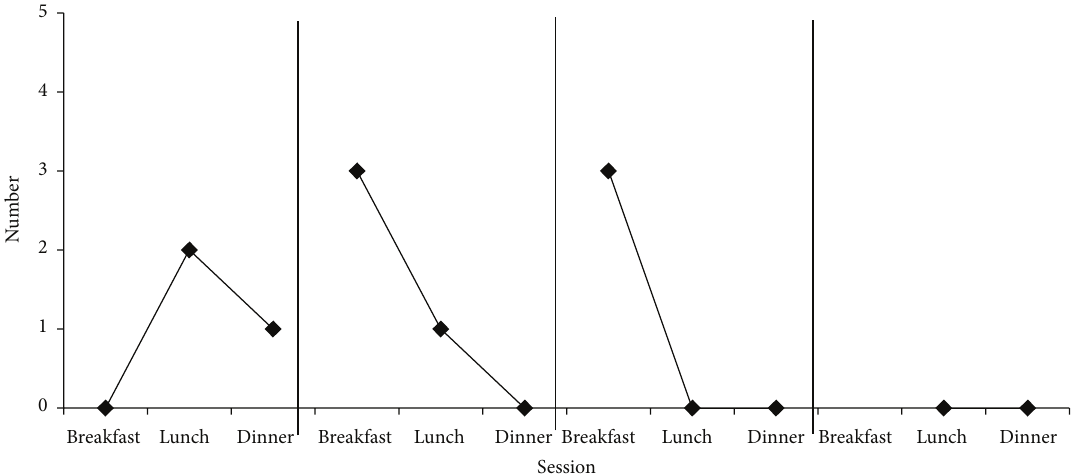
Figure 2: Frequency of gags and